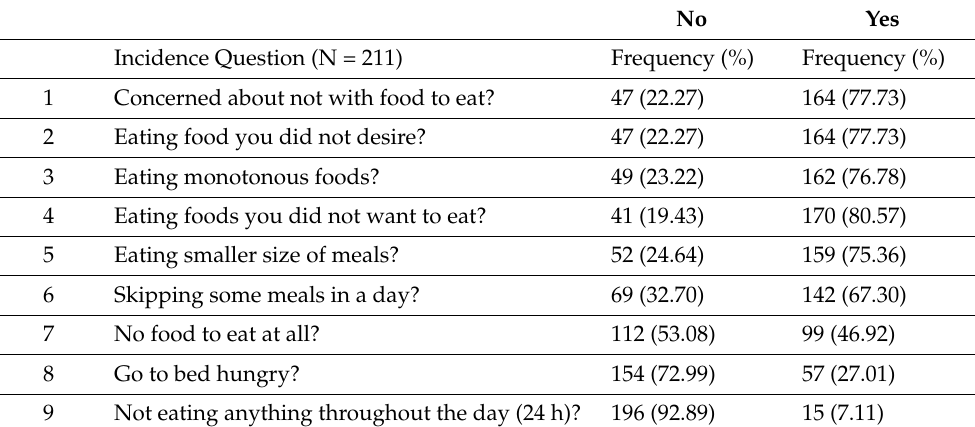
Table 4. Distribution of farming households based on the incidence of food insecurity